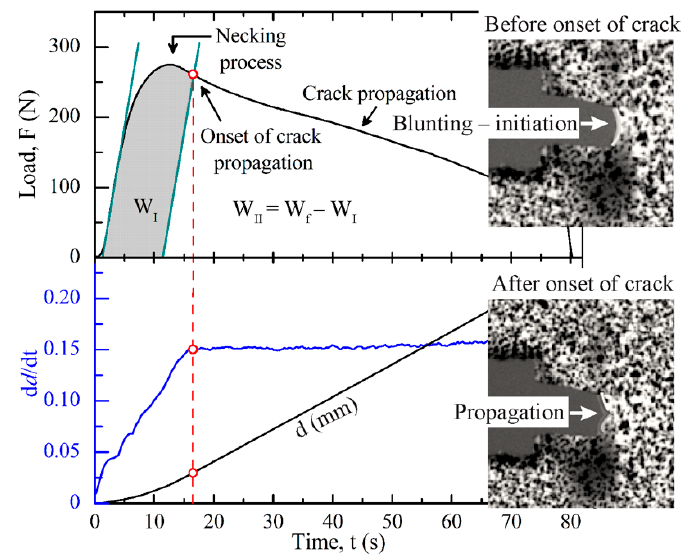
Figure 2. Energy partition illustrated in a load–time curve of 90/10 blends obtained from EWF tests. Also shown below is the derivative analysis of the strain rate of the tested sample. Insets: the notch tip zone images taken an instant before and after the onset of crack propagation.